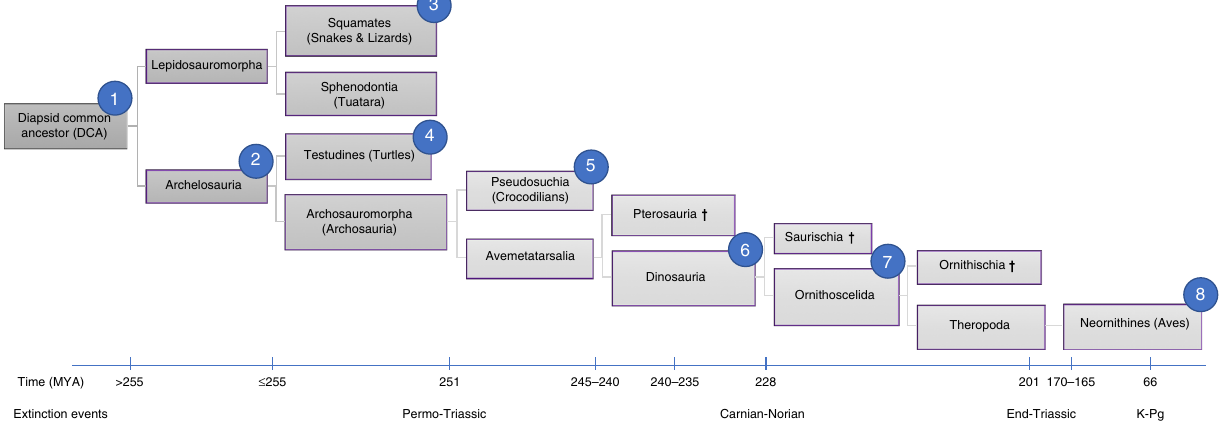
Fig. 3 Representative phylogenetic tree illustrating the lineage investigated in this analysis. For ease of reading, the timelines are not to scale. The major extinction events and the principal fi ndings of this study are highlighted in the context of this phylogeny as follows. (1) DCA karyotype reconstructed by MGRA2 analysis. (2) Cytogenetic analysis revealed the basic 'avian' pattern 2 n = 66 mostly in place before archelosauria divergence. (3) One lizard ( A. caroliensis ) studied genomically and cytogenetically. (4) Two turtles ( T. scripta and A. spinifera ) studied cytogenetically. (5) Crocodilian genomes not considered suitable for analysis because of fragmented genome assemblies and fused chromosomes. (6) Early emerging dinosaurs and pterosaurs probably had at least 2 n = 66 and up to 2 n = 80 with typical avian pattern. (7) Theropod dinosaurs and possibly other groups probably had close to 2 n